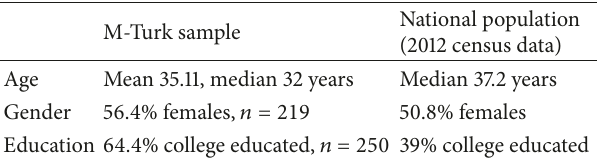
Table 2: Demographic information for participants in Experiment 2 compared to 2012 US